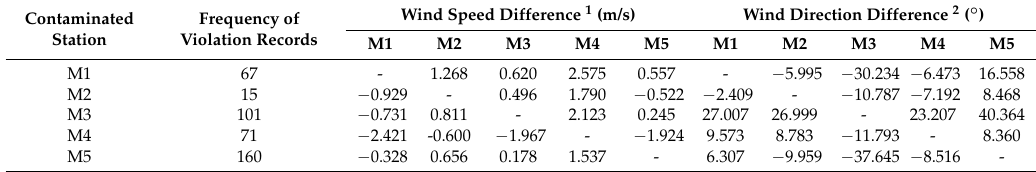
Table 2. Real-time wind speed and wind direction error for pollution episodes at each station.